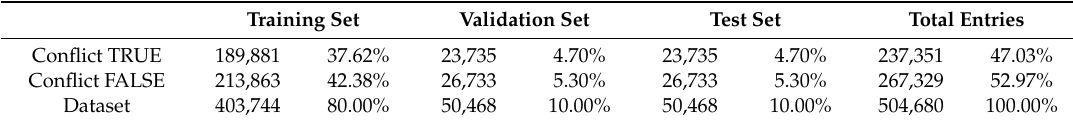
Table 4. Training database structure.